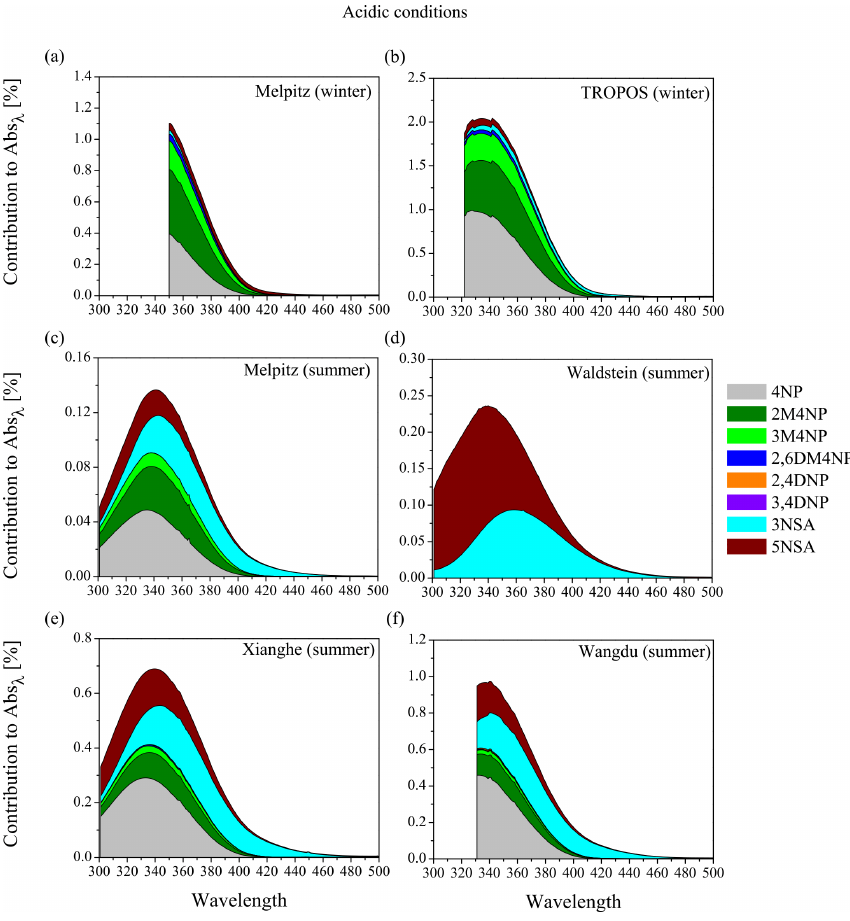
Figure 5. Relative contribution of NACs to Abs λ over the spectral range of 300 to 500nm for each measurement campaign (a–f) under acidic conditions. The data are presented as campaign averages. Due to instrumental issues, data for lower wavelengths are not always